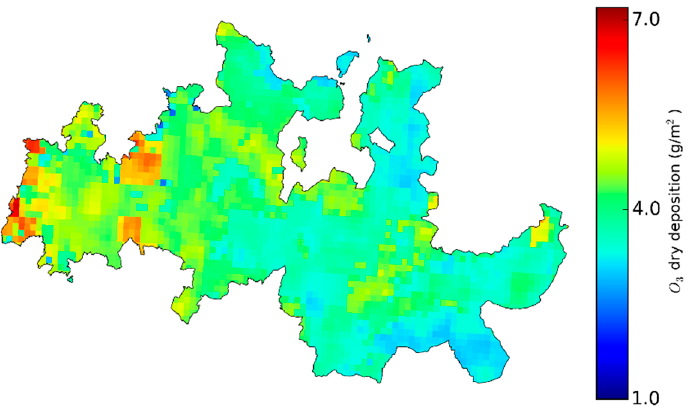
Figure 11. O 3 dry deposition (g · m − 2 ) in DDR (D04, 1 × 1 km 2 horizontal resolution), accumulated from May to July and averaged for the 3 simulation years.